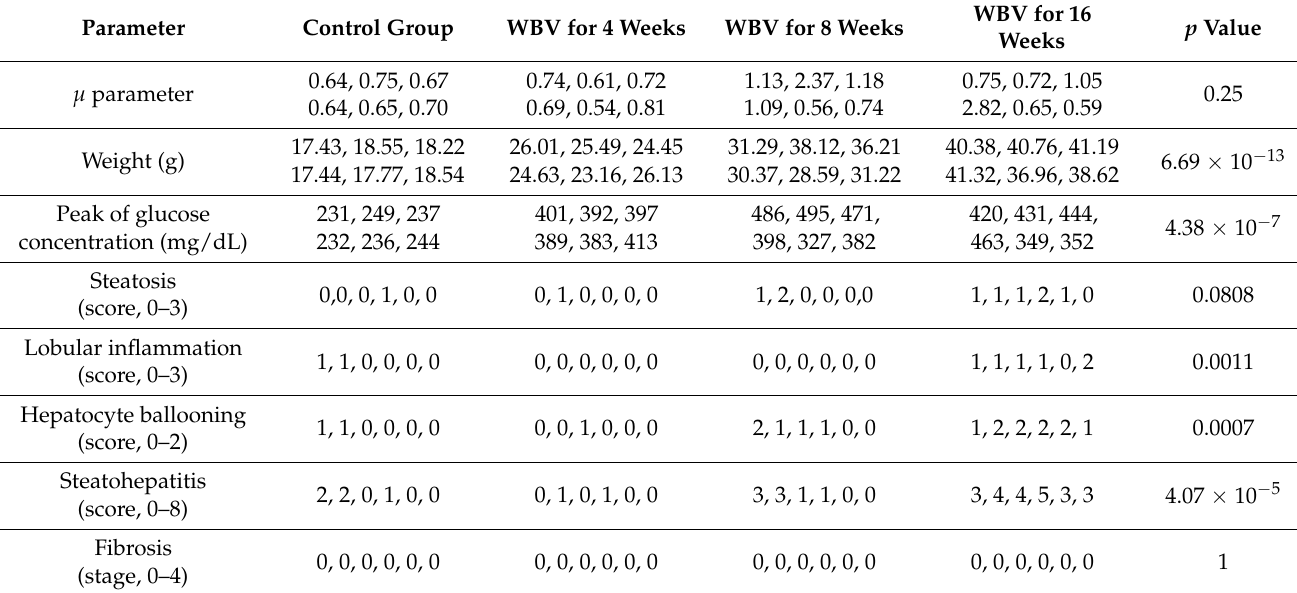
Table 3. Changes in steatosis, steatohepatitis, and fibrosis in the whole-body vibration group (the normality test failed, and thus ANOVA on ranks was applied).